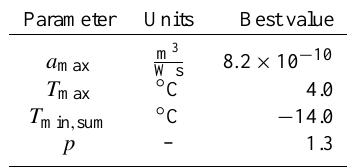
Table 1. Optimal parameter values for Eqs. (5) and